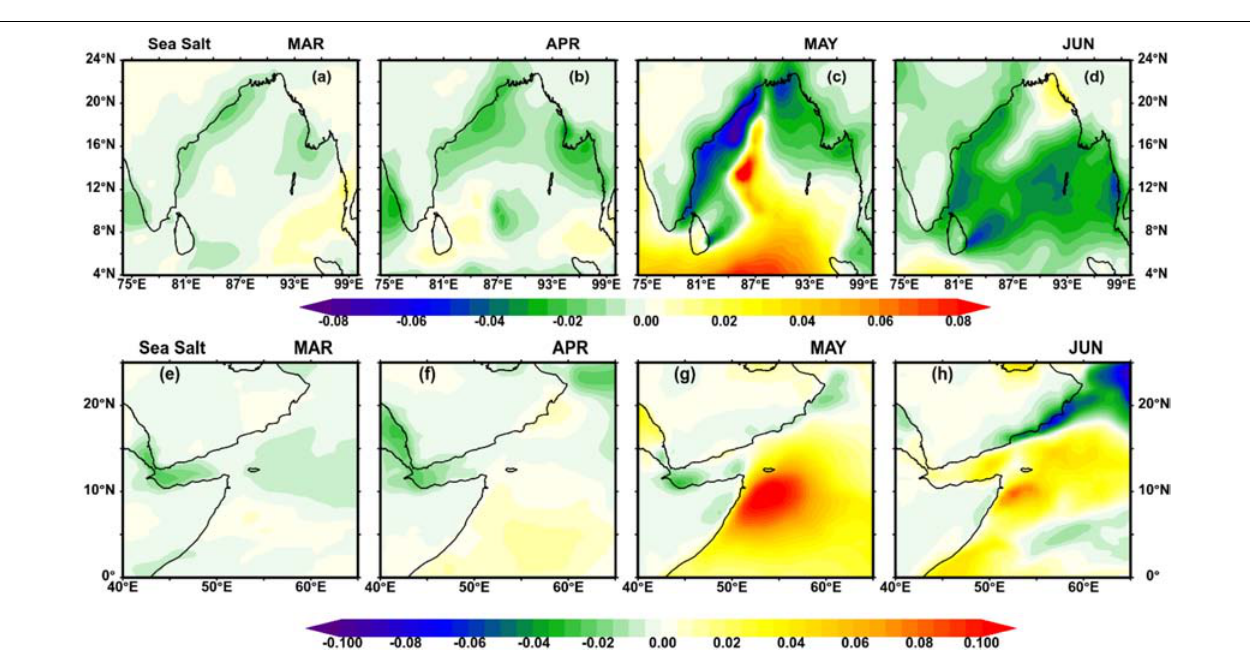
sensors with 4 km horizontal and daily temporal